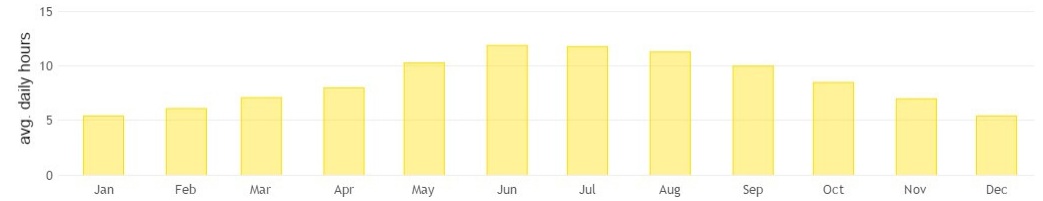
Figure 4. Average daily sunshine in Irbid (http://weather ‐ averages.com).